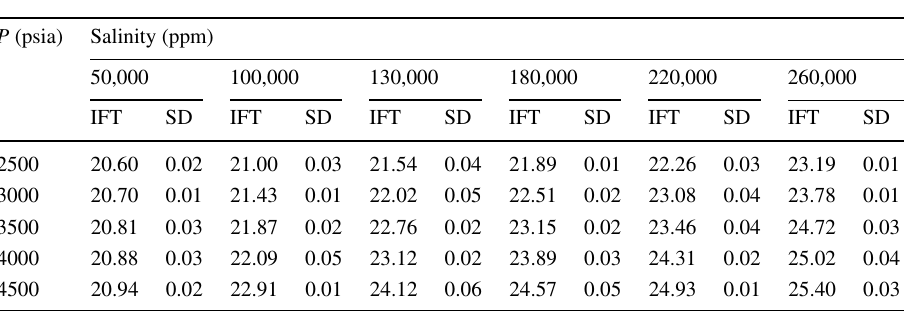
Table 8 Data related to the IFT measurement of Figs. 3 and